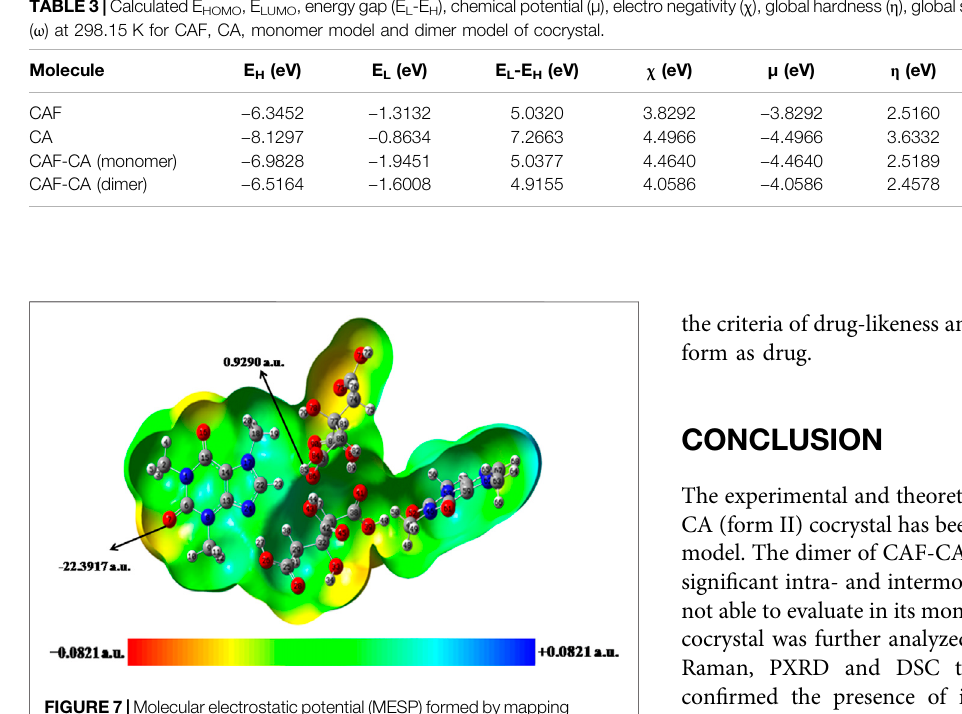
FIGURE7| Molecularelectrostaticpotential(MESP)formedbymapping of total density over electrostatic potential in the gas phase for dimer model of